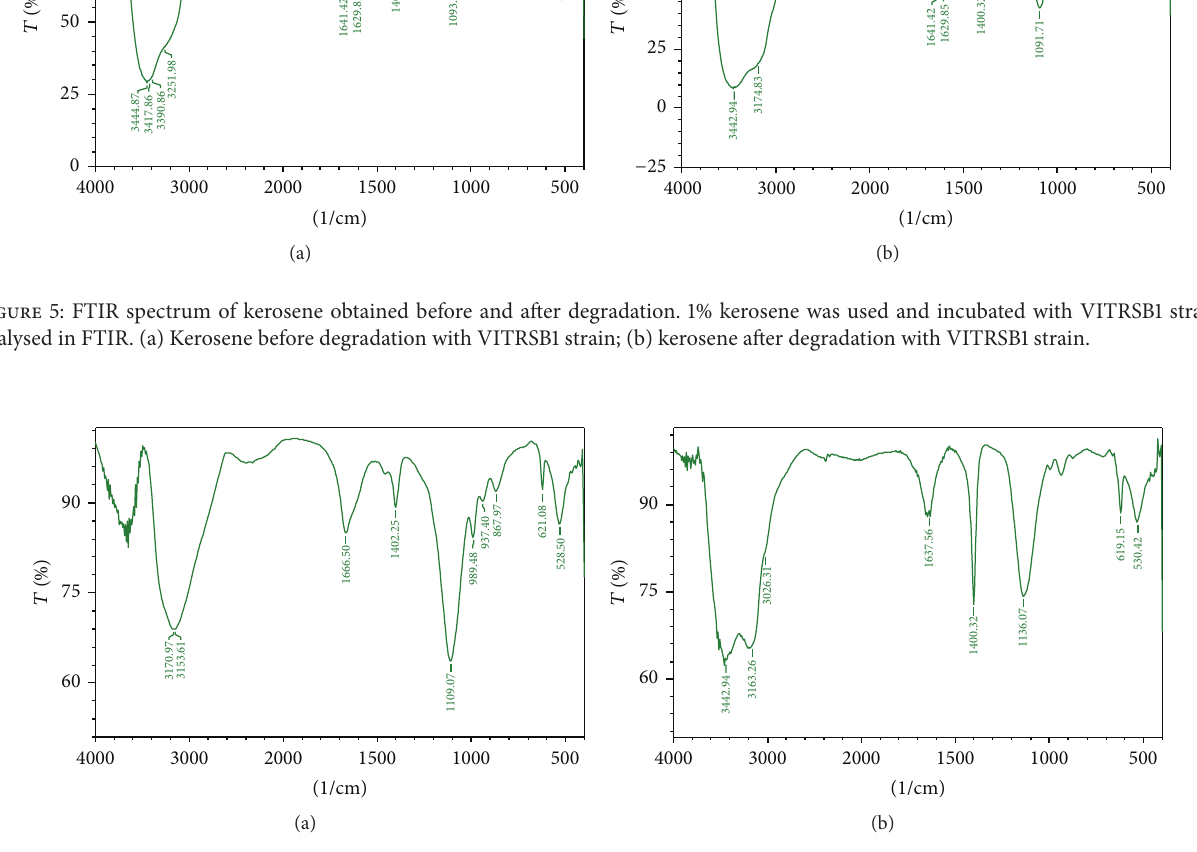
Figure 6: Naphthalene degradation spectra obtained before and after degradation. 1% naphthalene was used and incubated with VITRSB1 strain and analysed in FTIR. (a) Naphthalene before degradation with VITRSB1 strain; (b) naphthalene after degradation with VITRSB1 strain.